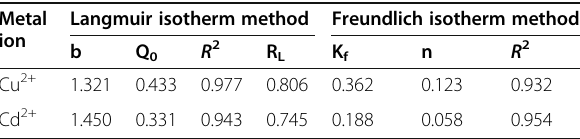
Table 7 Parameters of Langmuir and Freundlich isotherms for sorption of metal ions on Phanerochaete chrysosporium immobilized bentonite